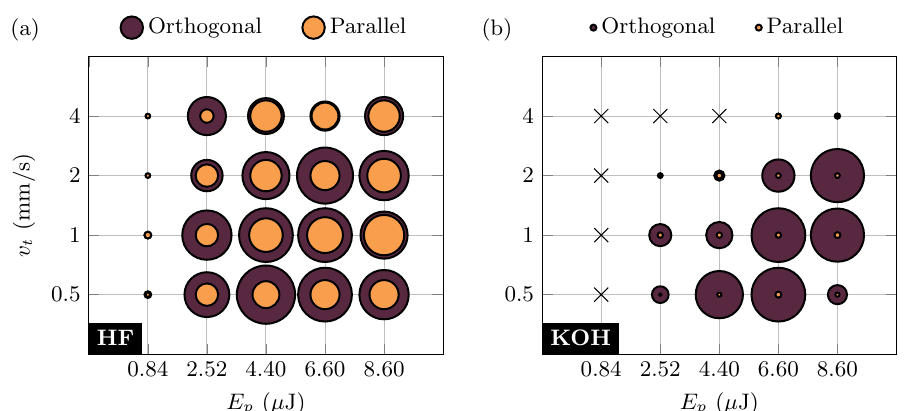
Figure 2. Characterisation of the A.R. of the etched cones as a function of the irradiation parameters: pulse energy E p , translation speed v t , and polarisation (parallel or orthogonal with respect to the translation direction). The repetition rate of the laser pulses is 25 kHz. The area of the coloured circles indicates the A.R. of the cones, as measured ( a ) after 10 min of etching in HF solution or ( b ) after 6 h in KOH solution. The size of the circles in the legend corresponds to a value of